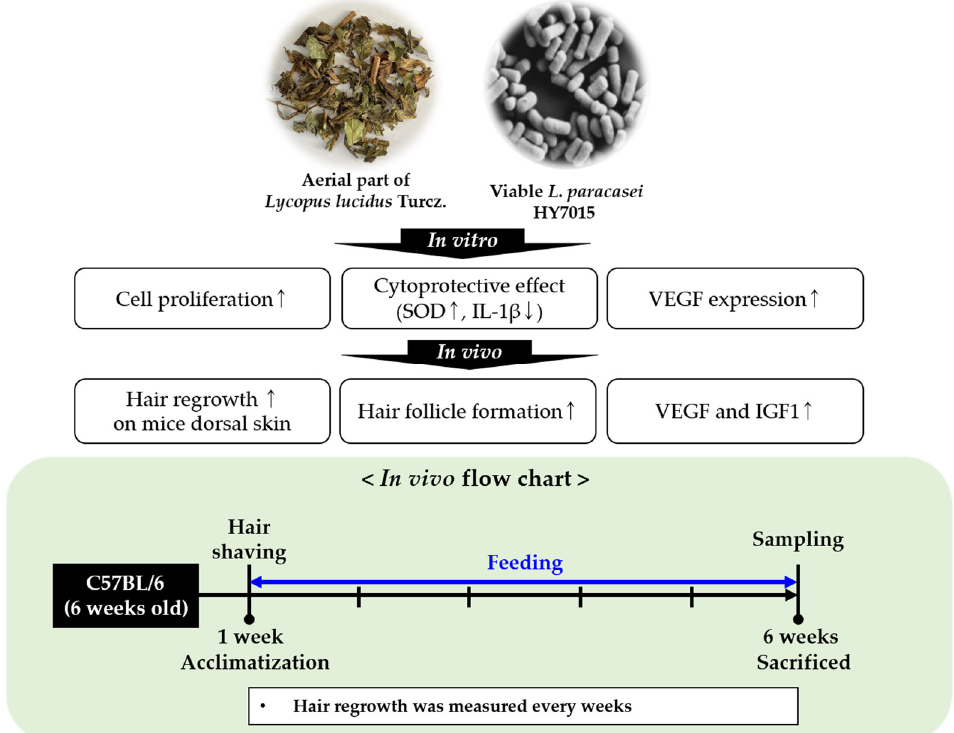
Figure 8. The flowchart of in vitro and in vivo .